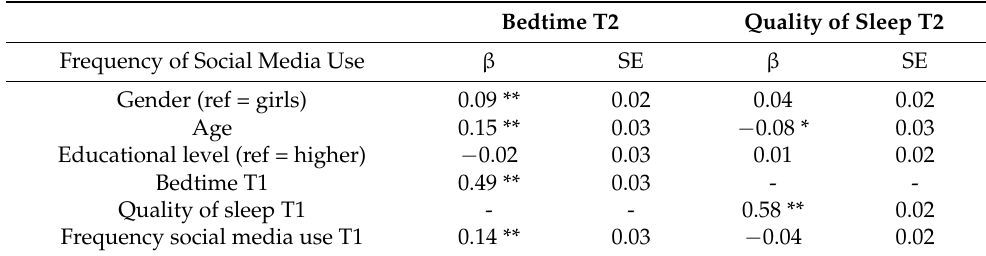
Table 2. Structural equation model of the effects of the frequency of social media use and problematic social media use separately and jointly on bedtime and perceived quality of